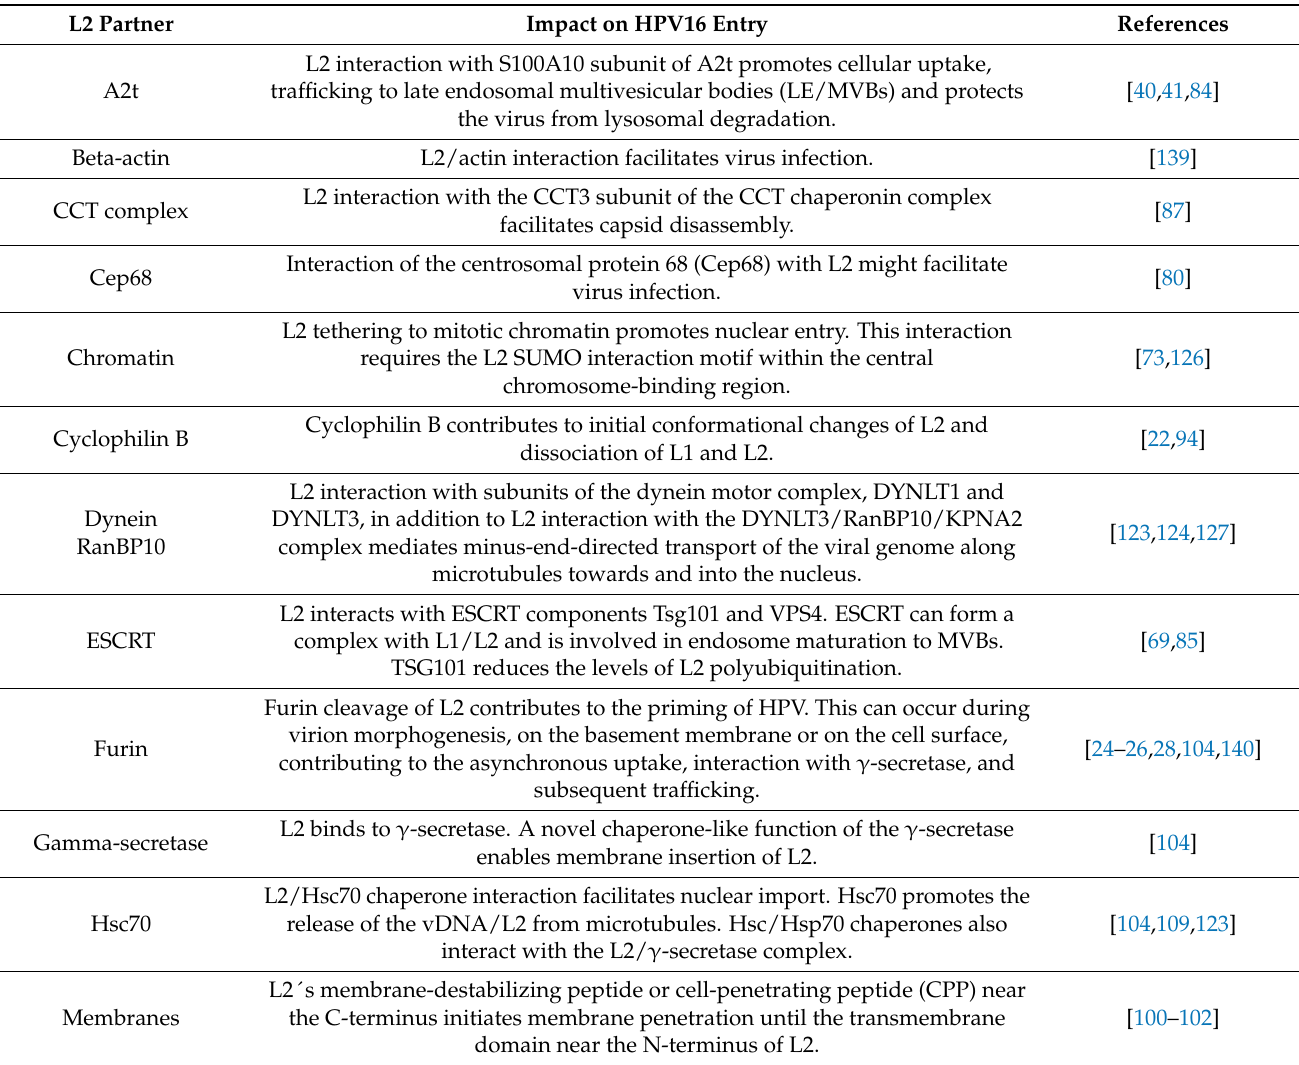
Table 2. Interaction partners of the HPV16 minor capsid protein L2 are listed in alphabetical order. L2 Partner Impact on HPV16